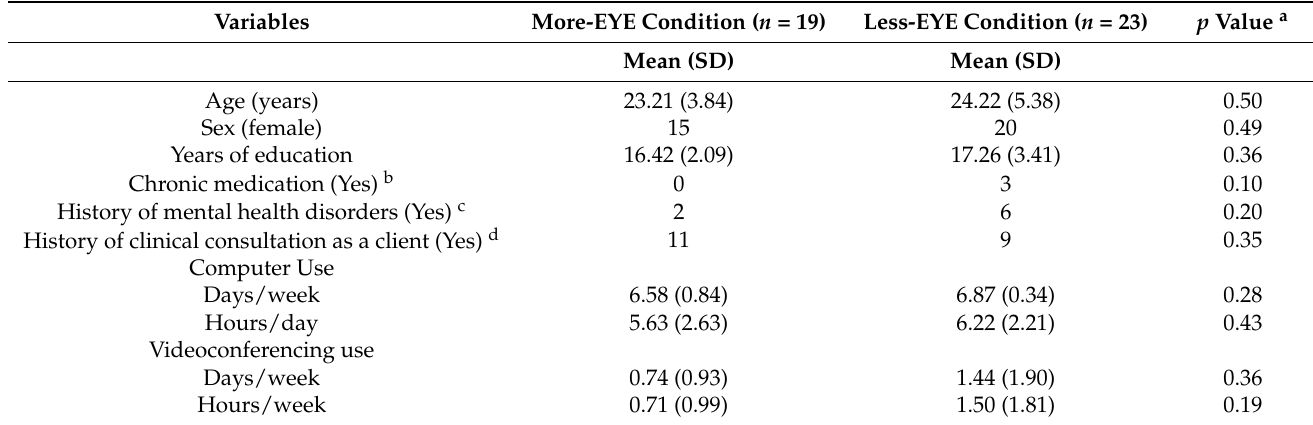
Table 1. The sociodemographic data of clients across the experimental